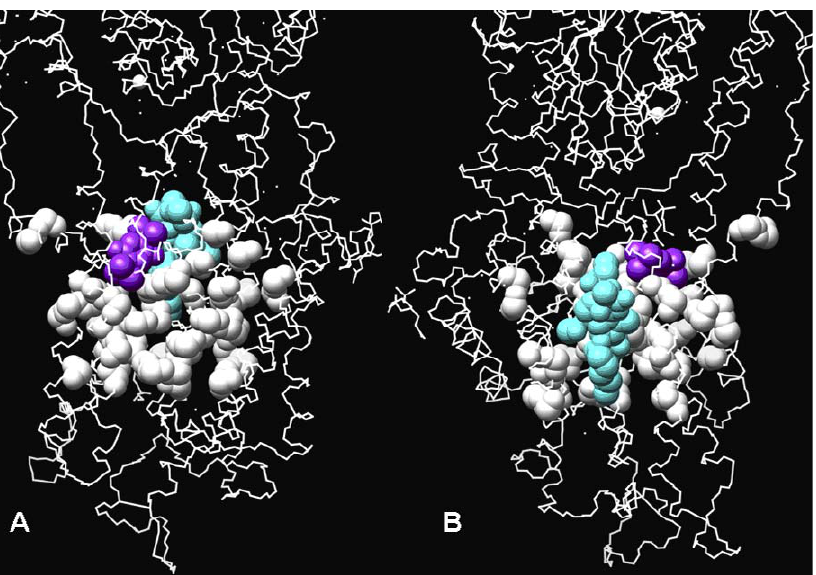
Figure 1. Comparison of the Predicted SERCA Ligand Binding Site with That of Known SERCA Inhibitors TG1 and BHQ The predicted binding site is represented by white spheres, BHQ by purple spheres, and TG1 by cyan spheres. (A) and (B) are two different perspectives centered on BHQ and TG1, respectively.